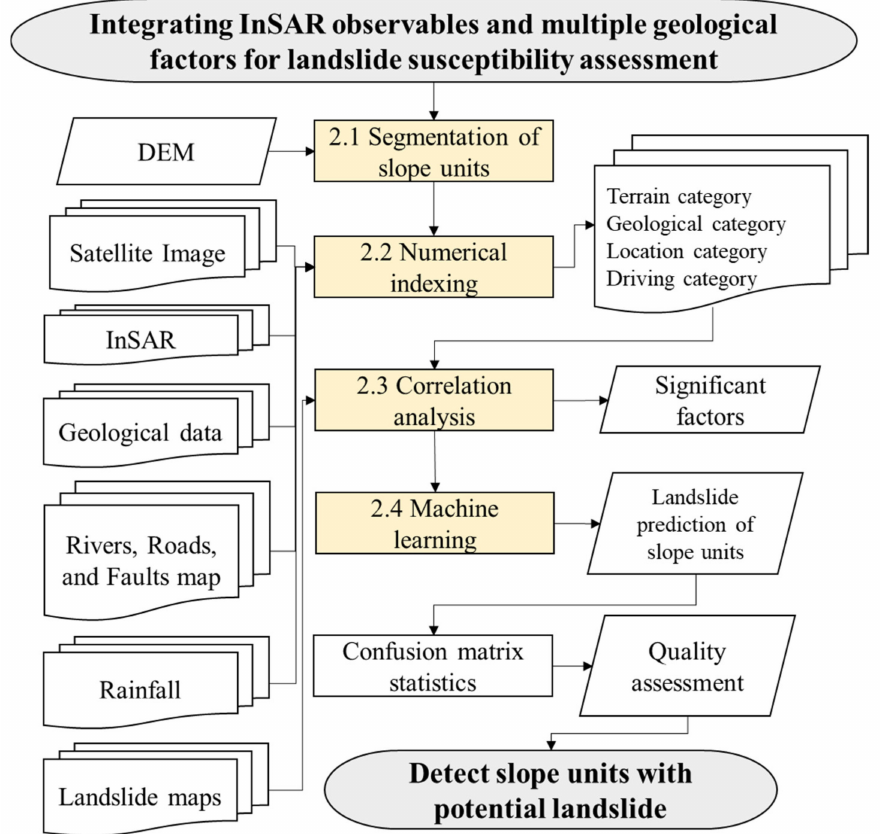
Figure 1. Flowchart of landslide susceptibility analysis based on the spatial factors with machine learning